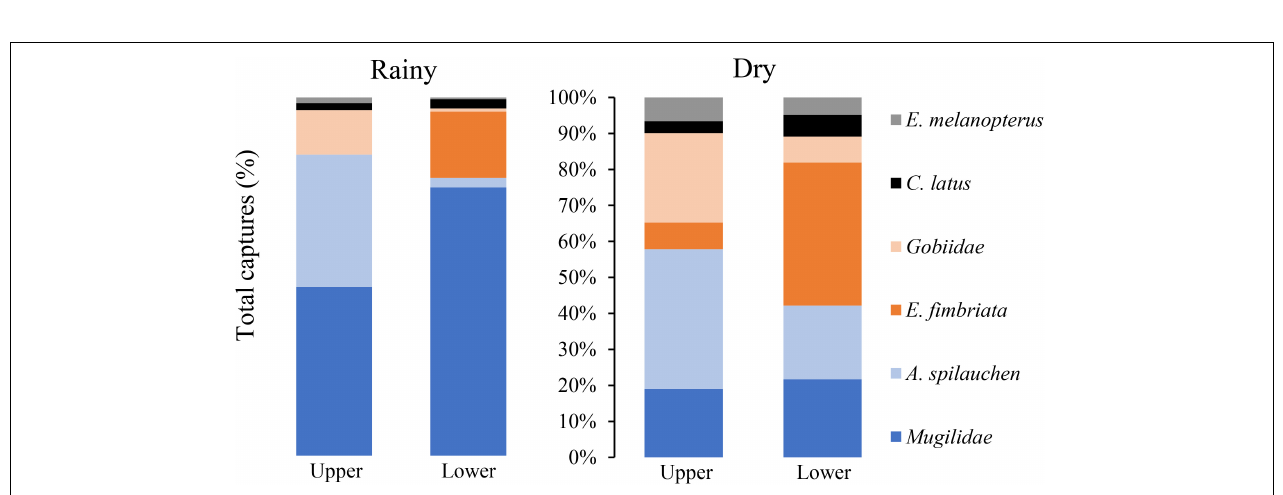
FIGURE 5 | Distribution of the fish taxa (%) according to mangrove location (upper or lower) in the rainy and dry season.